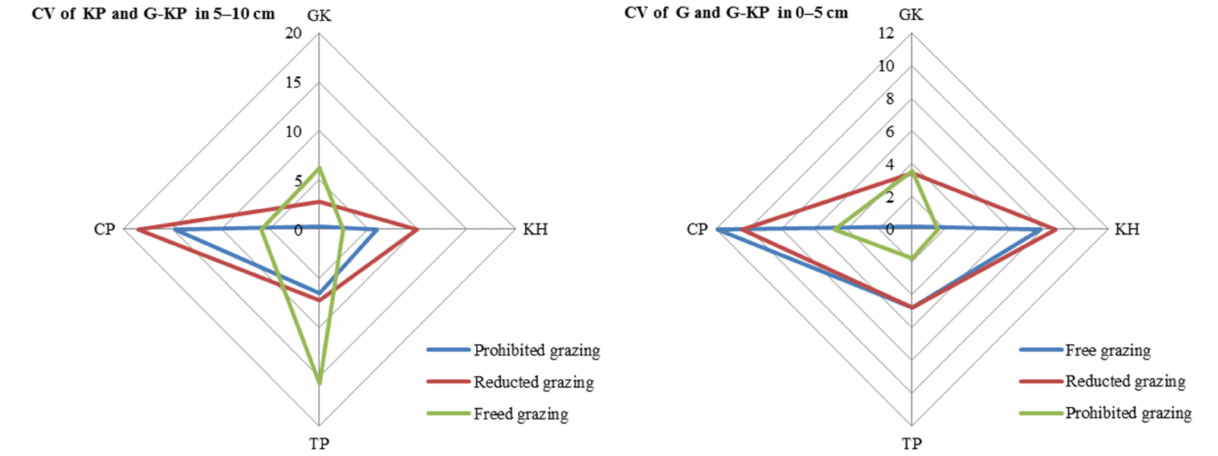
Figure 4. Variation in soil organic matter content between micro-patches in the plant community degradation process. Notes: CV of KH and G-KH: coefficient of variation at the 0–5 cm layer between the Kobresia and Kobresia -Gramineae transitional micro-patches, respectively; GK, Gramineae- K. humilis meadow; KH, K. humilis meadow; TP, K. pygmaea meadow with mattic epipedon thickening; CP, K. pygmaea meadow with mattic